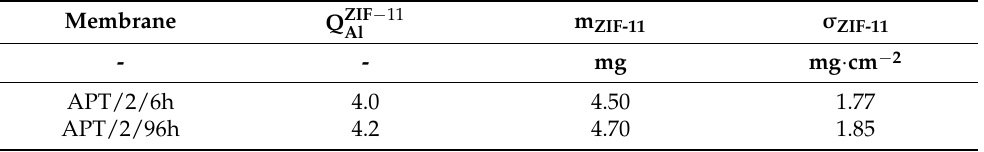
Table 3. Comparison of crystallinity Q ZIF − 11 , the deposited ZIF-11 mass (m ZIF 11 ), and the ZIF-11 Al loading σ ZIF-11 on two APT stainless-steel supports coated two times for different reaction